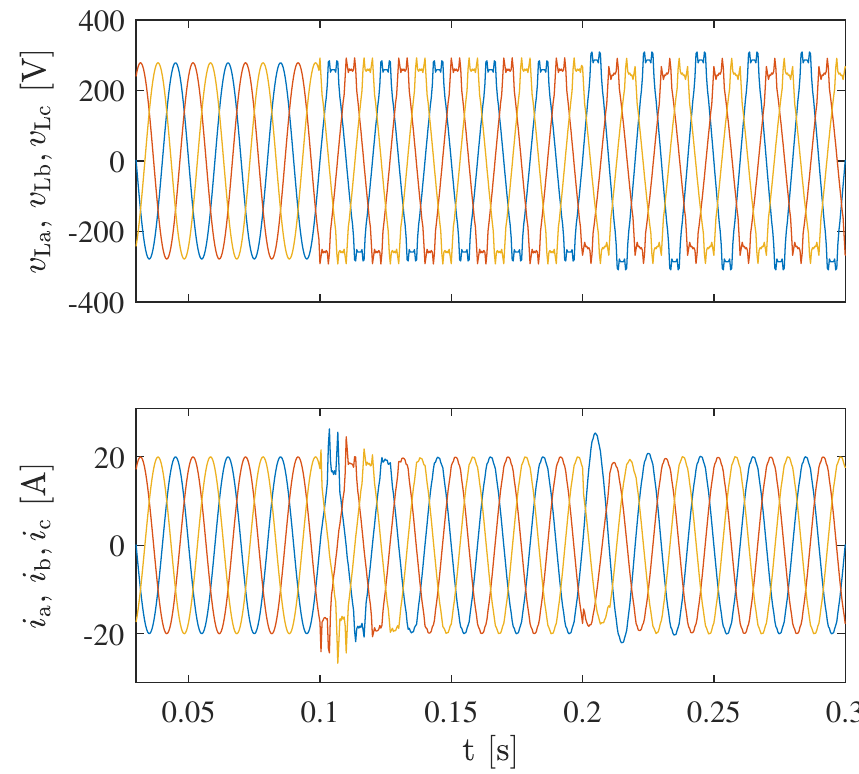
Figure 12. Grid voltages and phase currents (zoom).